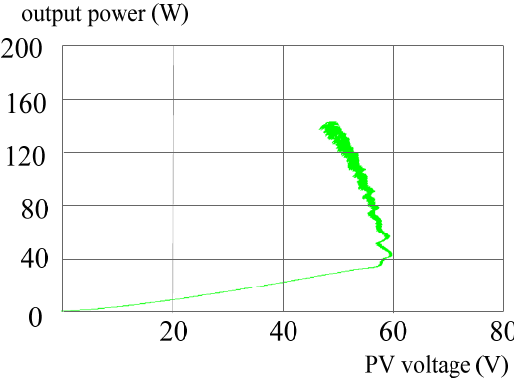
Figure 14. MPPT trajectory by the POM while irradiation and temperature